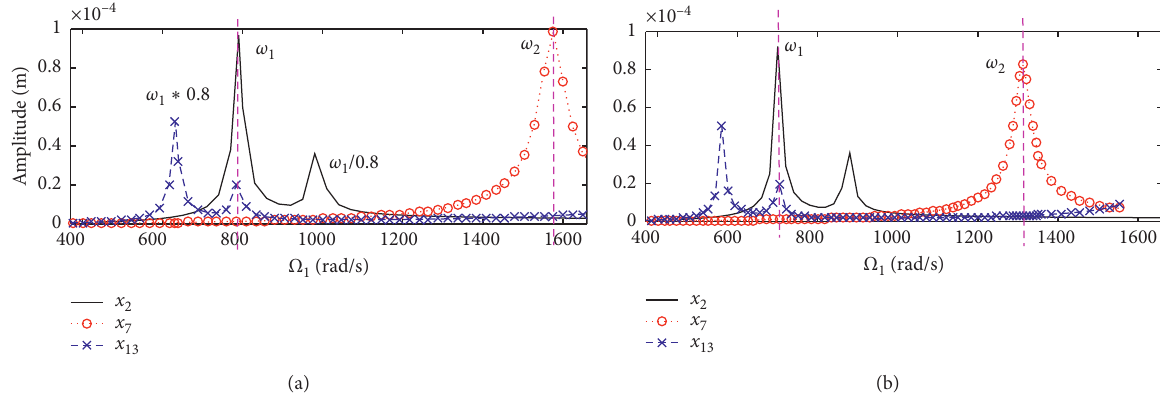
Figure 5: Vibration amplitudes versus rotation speeds for the blade-dual-rotor-support system ( x of the x -direction of the node 2, node 7, and node 13). (a) Case A. (b) Case